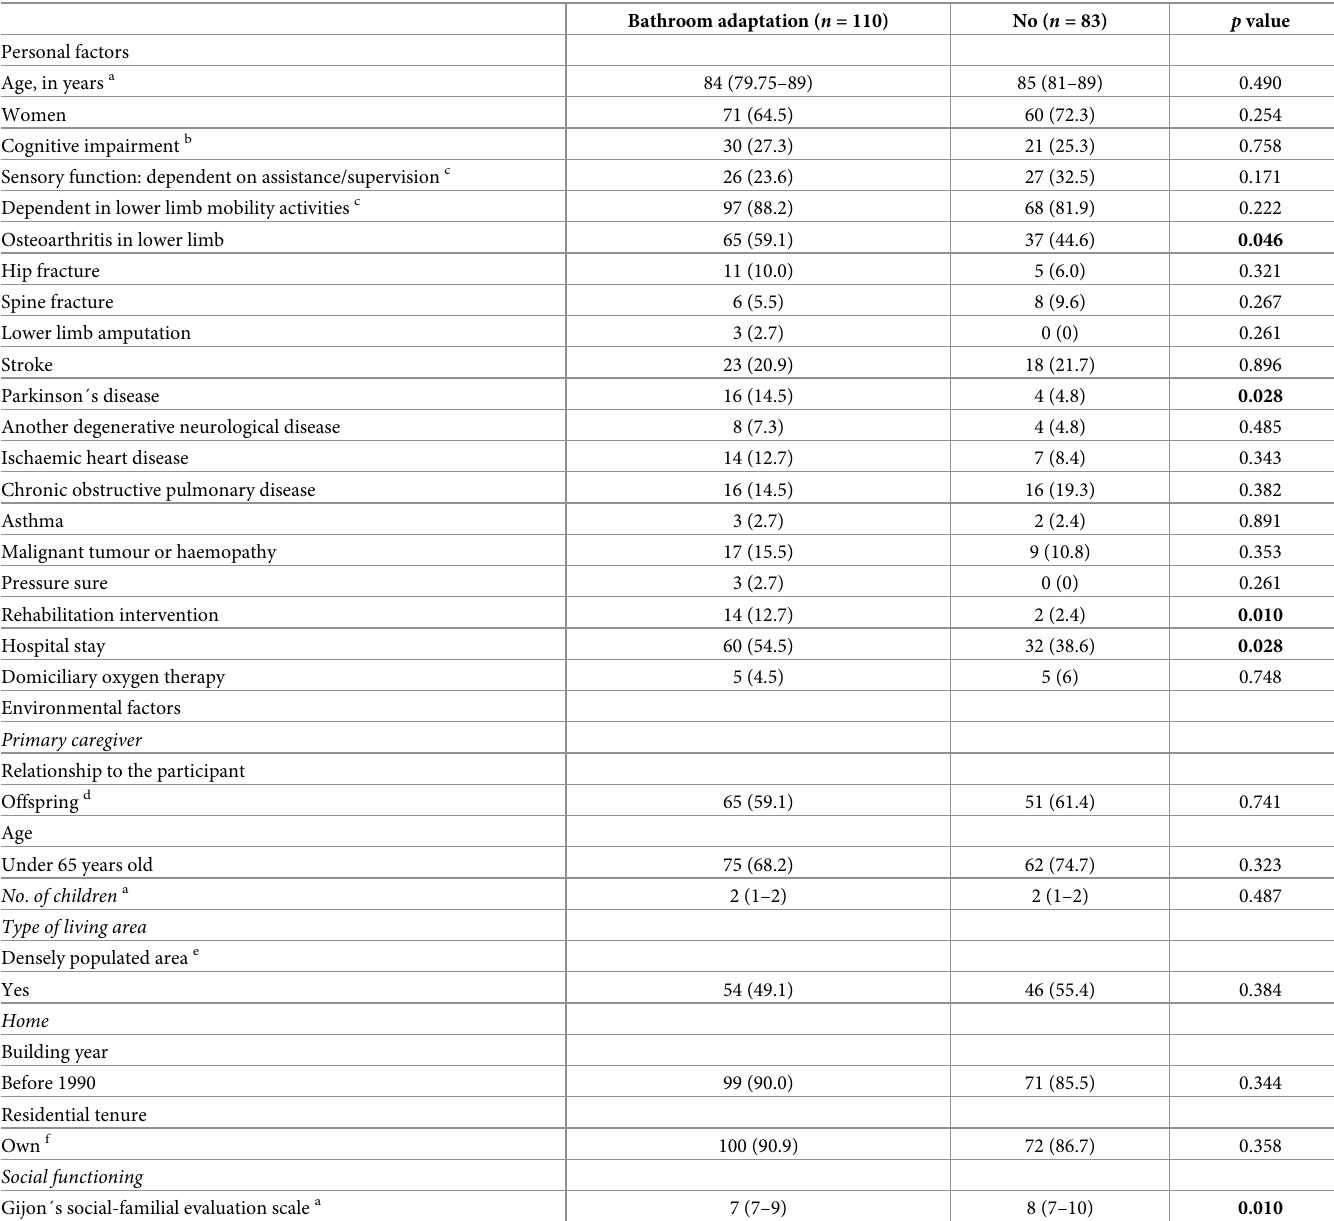
Table 4. Bivariate relationship between the implementation of a bathroom adaptation (in the last two years) and personal and environmental factors ( n =